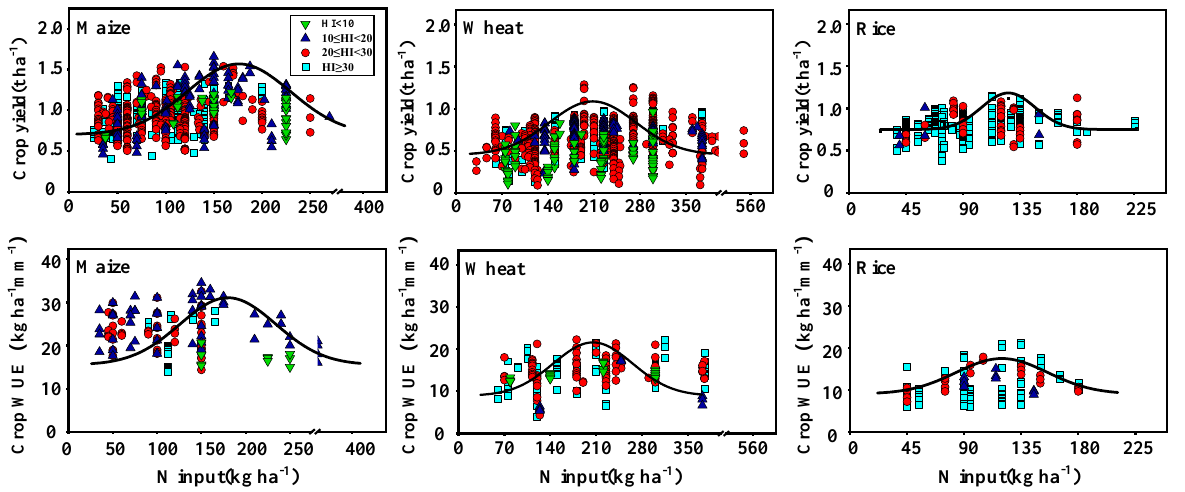
Figure 4. The crop yield and WUE according to N input (kg ha − 1 ). The solid lines are fitted by non-linear regression model to yield and WUE datasets of maize, wheat, and rice. Triangles represent field experiment of maize, squares represent field experiment of wheat, and circles represent field experiment of rice. The color of symbol represents HI.